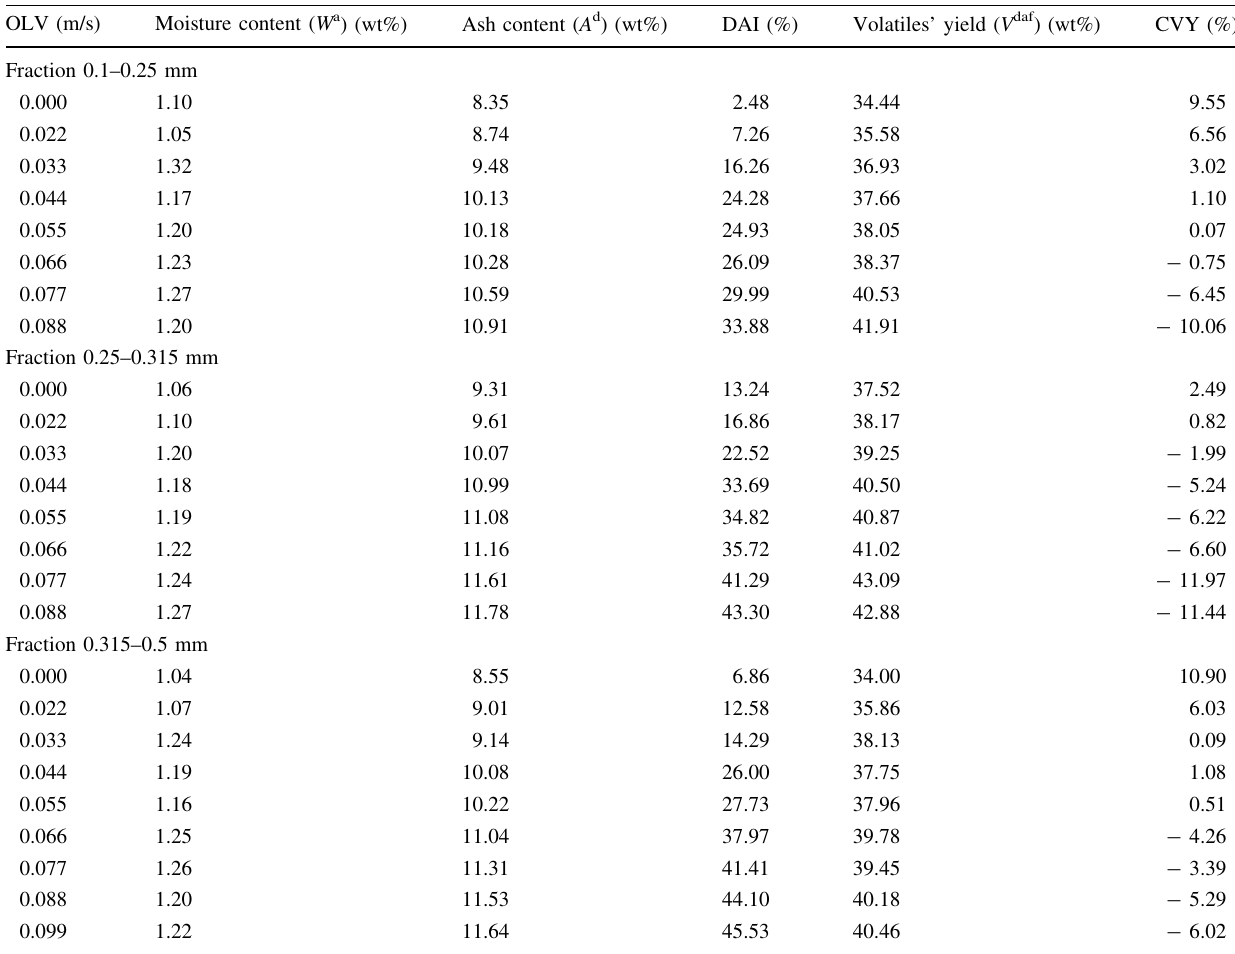
Fraction 0.25–0.315